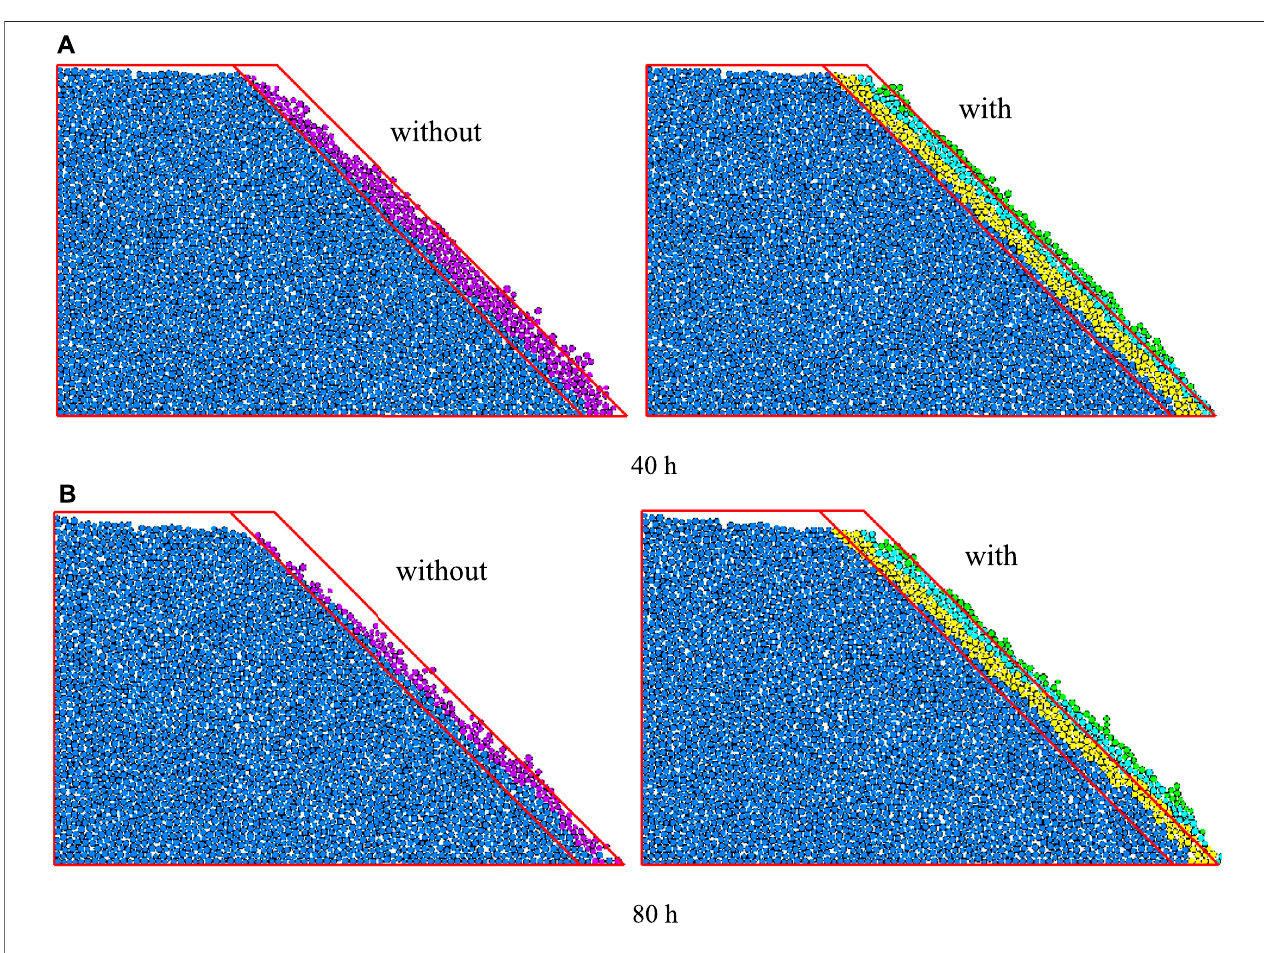
FIGURE 15 | Comparison of runoff erosion failure mechanisms without and with composite slope protection at. (A) 40 h and (B) 80 h